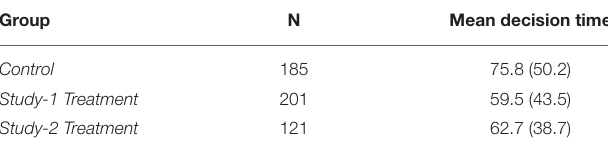
TABLE 4 | Mean decision times in seconds by group ( SD in